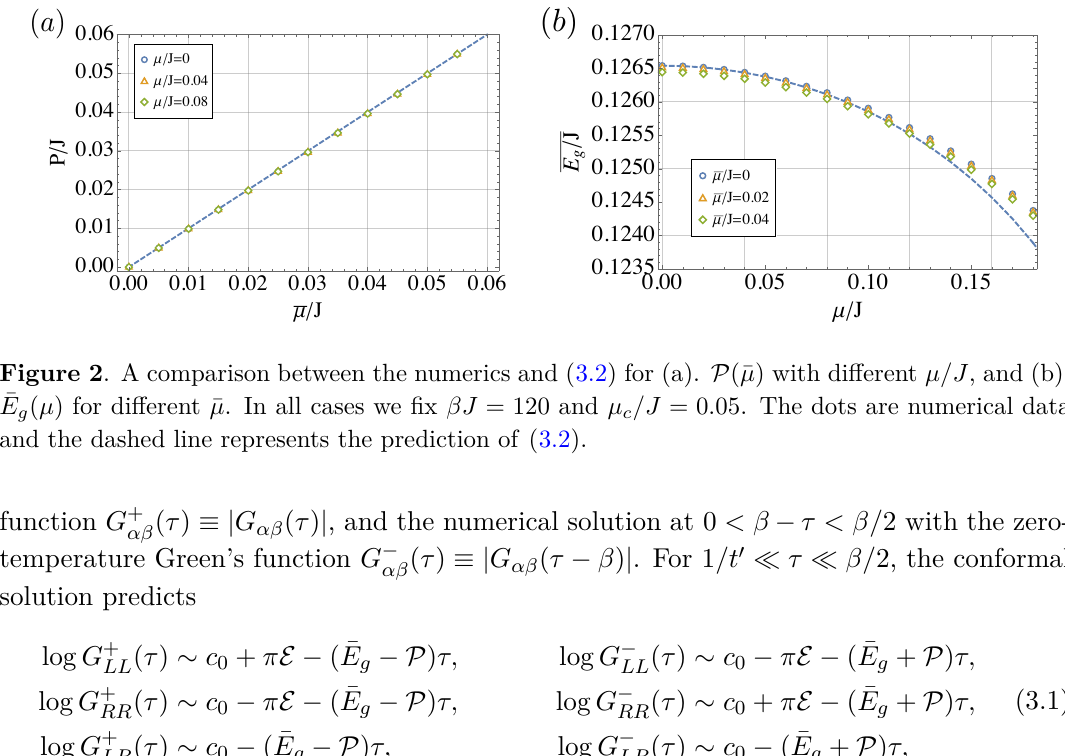
Figure 1 . (a). The imaginary-time Green’s function for βJ = 120 , ¯ µ/J = 0 . 05 , µ/J = 0 . 1 , and µ c /J = 0 . 05 . (b). A zoom in of (a) near 1 /t 0 (cid:28) τ (cid:28) β/ 2 or 1 /t 0 (cid:28) β − τ (cid:28) β/ 2 . We can see the numerical results are consistent with (2.9).